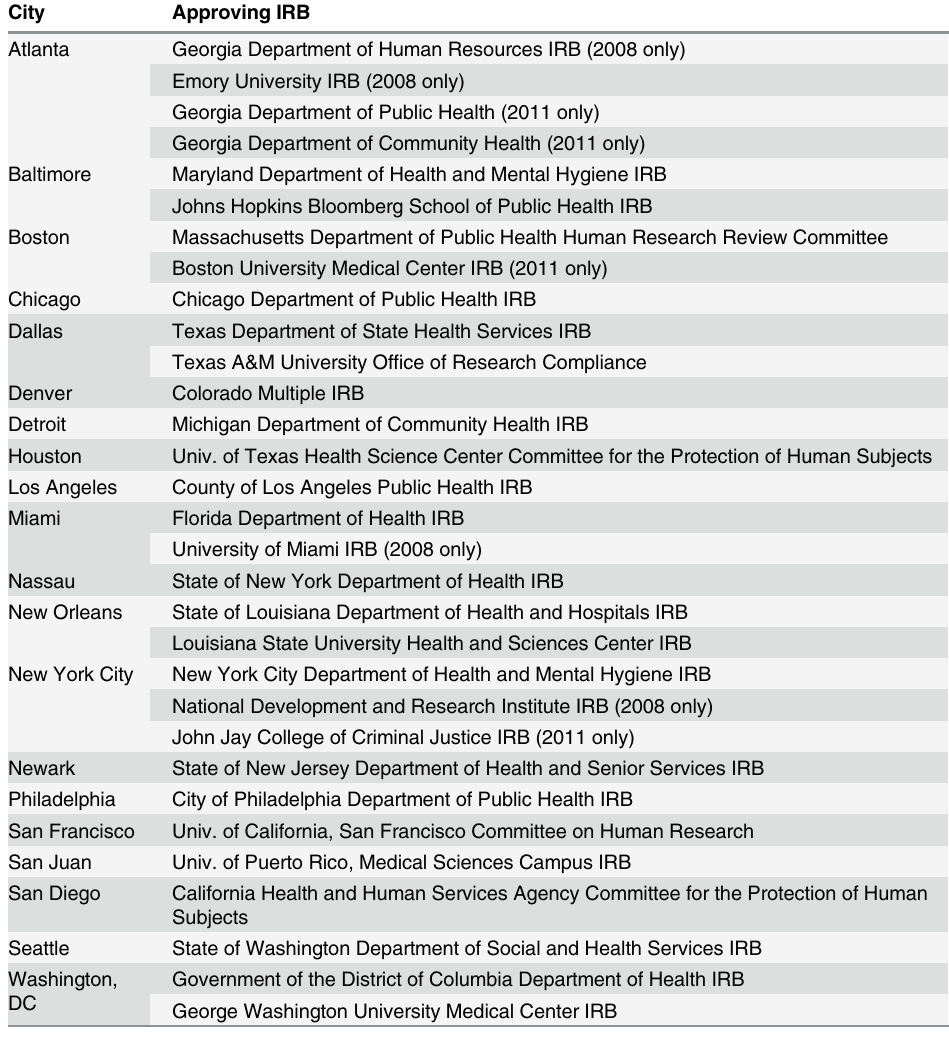
Table 1. Approving Institutional Review Boards (IRBs) for NHBS-MSM Activities (2008 and